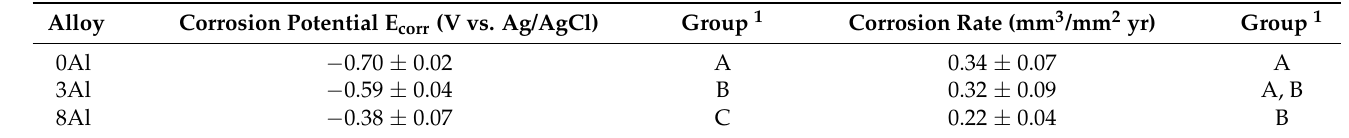
Table 5. Corrosion potential values (compared to the Ag/AgCl reference electrode) and corrosion rates of the materials.